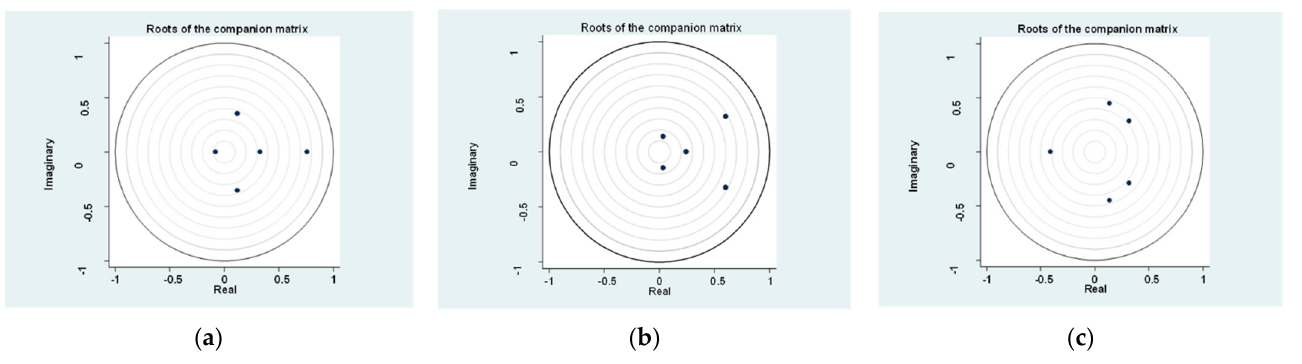
Figure 2. Stability Conditions Panel Vector Autoregression Model. ( a ) GDP Shock. ( b ) Trade Shock. ( c ) Interest Rate Shock. Table 4. Moment and Model Selection Criteria (MMSC) for GDP Shock.